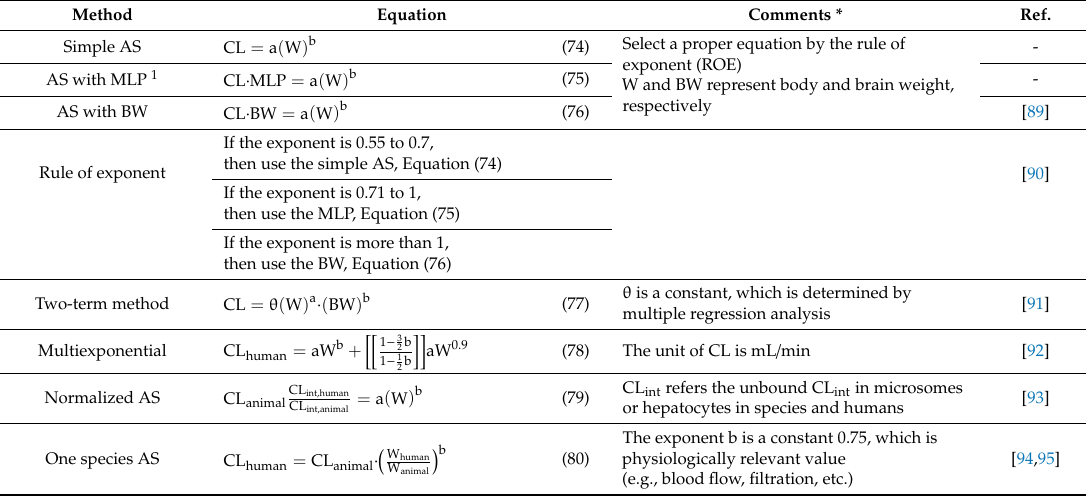
Table 3. Methods for prediction of clearance (CL) using allometric scaling